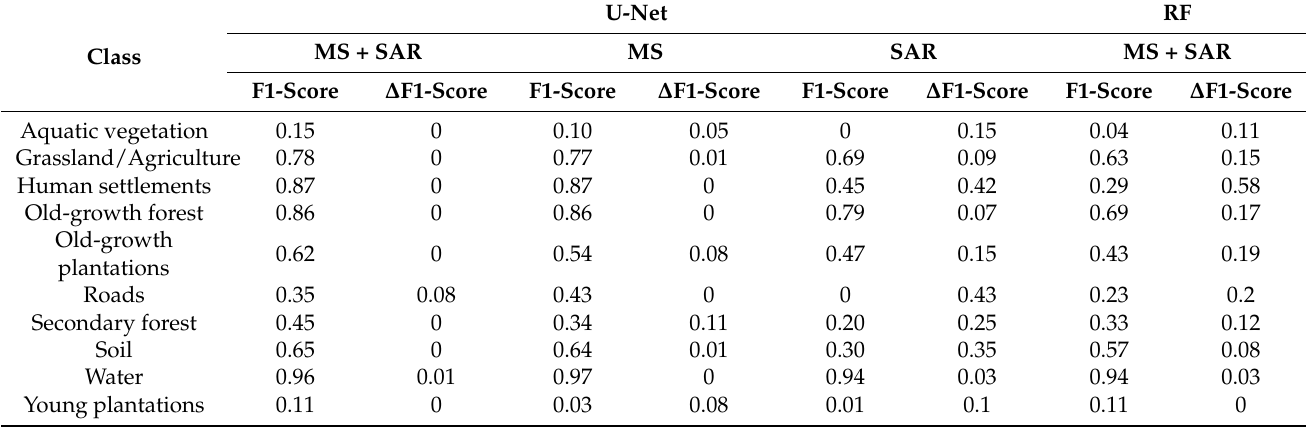
Table 1. F1-score and the difference from the highest score ( ∆ F1-score) for each class for the MS + SAR, MS, SAR U-net and MS + SAR Random Forests. MS: Multispectral bands, SAR: synthetic aperture radar bands, RF: Random forests.